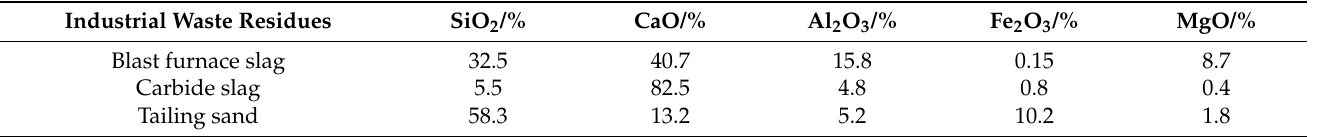
Table 2. Chemical composition of three industrial